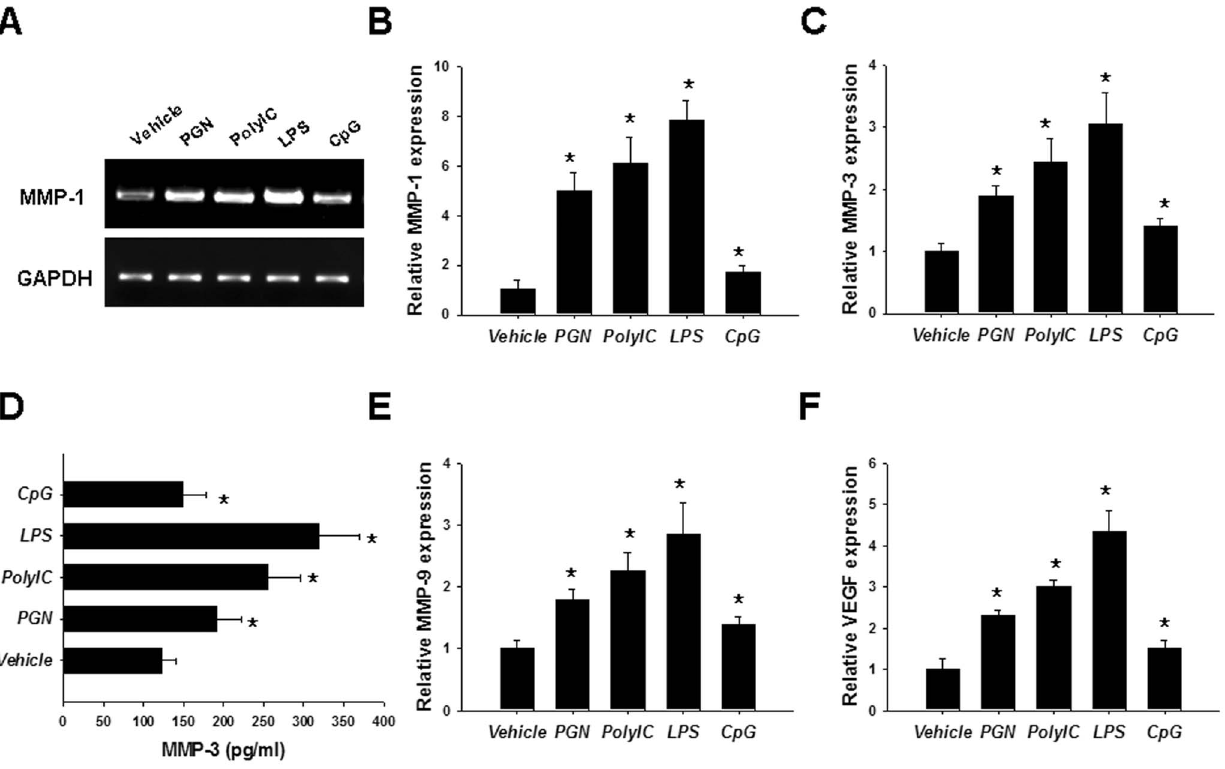
Figure 3. vLigation of TLRs stimulated MMPs and VEGF production in RASF. RASF were stimulated with 10 m g/ml PGN, 25 m g/ml ploy(I:C), 100 ng/mL LPS, or 10 m g/ml CpG for 4 h. Then the cells were harvested for RT-PCR analysis of MMP-1 (A); realtime PCR analyses of MMP-1 (B), MMP-3 (C), MMP-9 (E), and VEGF (F). And also, after stimulation for 24 h, the cell culture supernatants were collected for MMP-3 ELISA (D). The results were presented as mean + SEM of five independent experiments (Wilcoxon signed-rank test, * P , 0.05 vs. vehicle